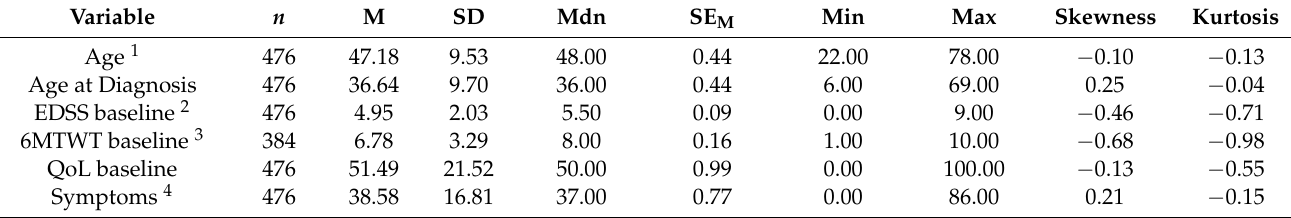
Table 3. Summary statistics for Age, Age at Diagnosis, 6MTWT, QoL, and Symptom Score.